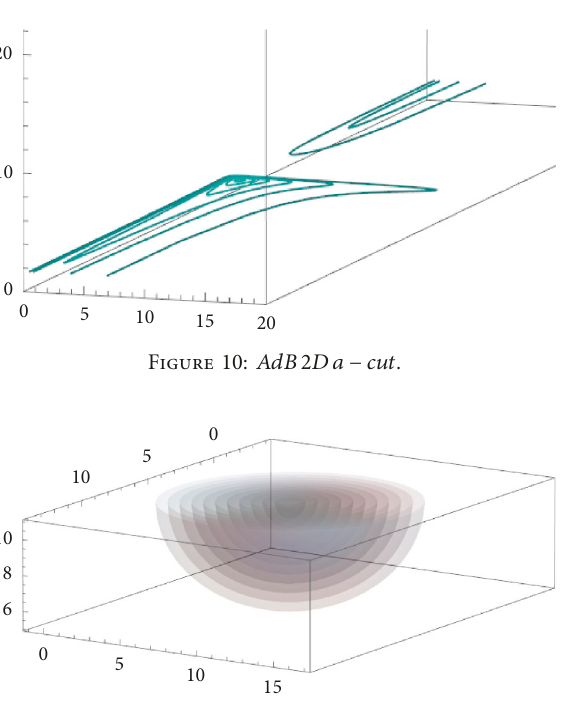
Figure 11: A + B 3 D half − cut .